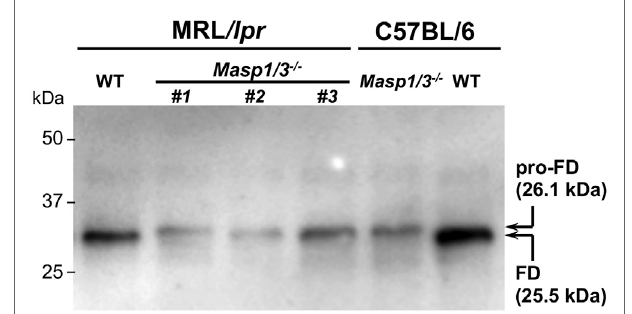
FigUre 2 | Immunoblotting for factor D (FD) in sera from 10- to 14-week-old MRL/ lpr and C57BL/6 mice. Serum FD were purified by immunoprecipitation with a rabbit anti-mouse FD antibody, deglycosylated with N -glycosylase F, separated by SDS-PAGE, and blotted onto a PVDF membrane. Purified pro-FD (26.1 kDa) and FD (25.5 kDa) were detected with a horseradish peroxidase-conjugated rabbit anti-mouse FD antibody. Consistent with our previous report on C57BL/6 mice (8), serum FD in Masp1/3 − / − MRL/ lpr mice was in an inactive form (pro-FD) when tested for serum samples from three independent Masp1/3 − / − MRL/ lpr mice (#1–3). In contrast, serum FD in WT MRL/ lpr mice was in an active form as well as in WT C57BL/6